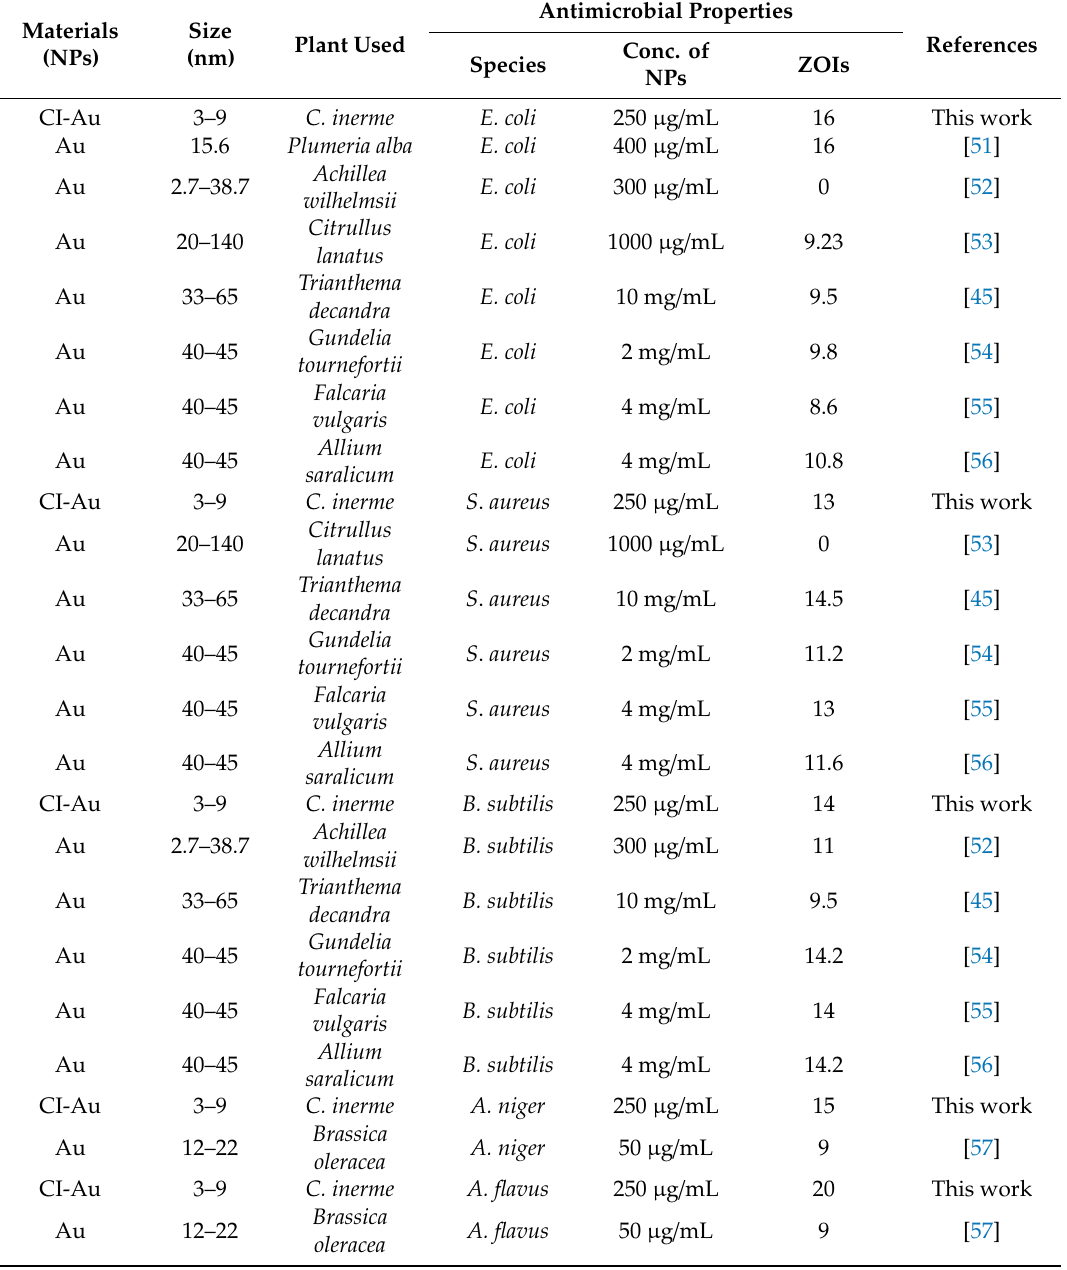
Table 2. Comparison of antimicrobial activities of green synthesized CI-Au NPs with reported Au NPs synthesized with other